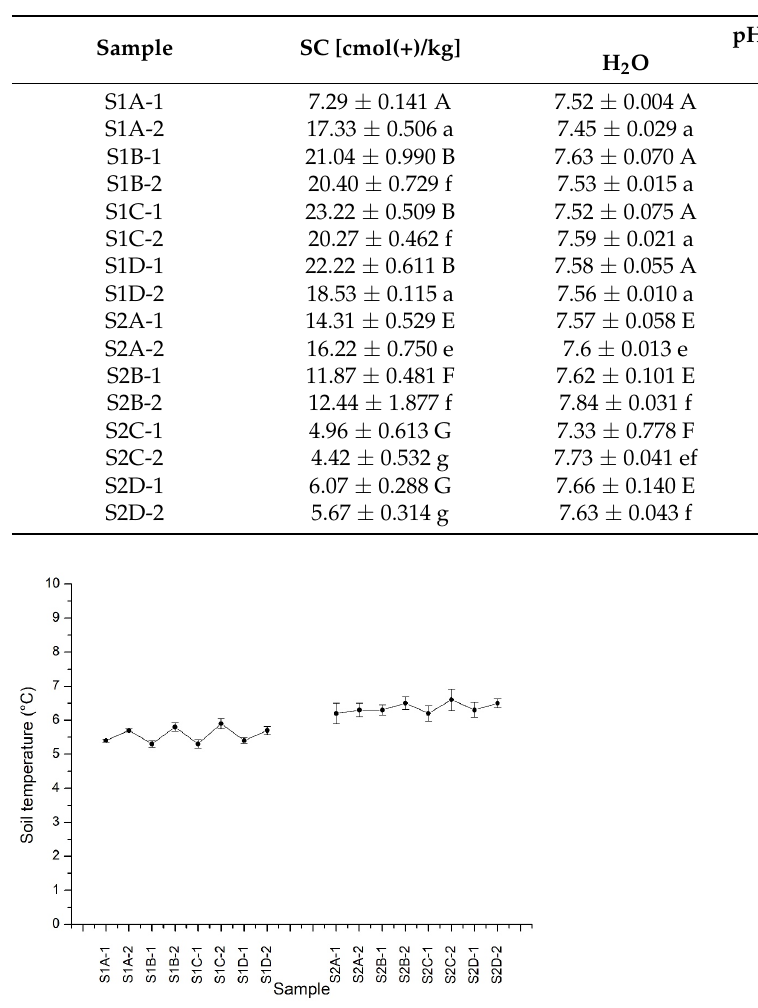
Table 2. Sorption capacity, and soil pH for the studied soils. S1: soil from the limestone open-cast mining remediated with embankment; S2: soil from the lignite open-cast mining remediated with sewage sludge; subsequent letters A–D mean different remediated areas located at the same mine site; subsequent numbers mean different sampling periods; 1: spring 2021, 2: spring 2022. Mean values ± SD, n = 3. Different letters in the columns indicate significant differences between tested treatments ( p < 0.05) according to Tukey’s test. Small and capital letters indicate separate analyses for both sampling soils (capital letters indicate the tests between soils collected in 2021, small letters in 2022).